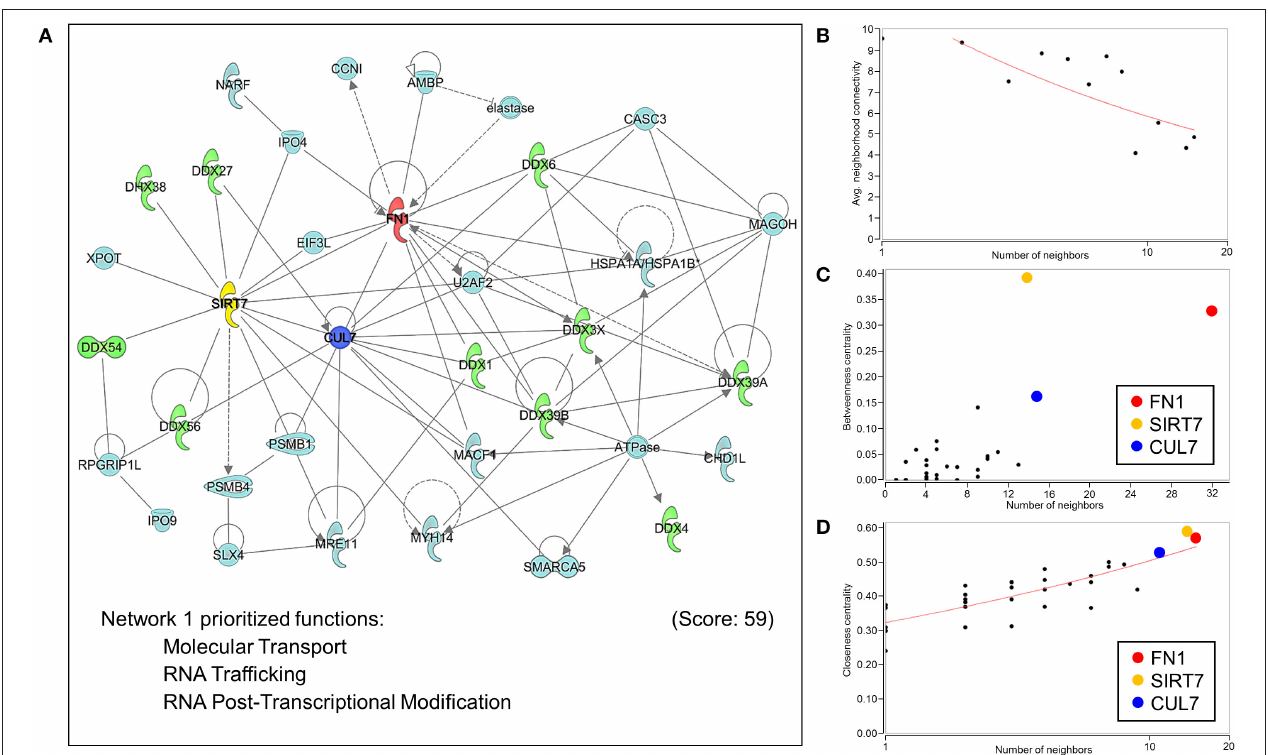
FIGURE 6 | Network analysis of protein-protein interactions of NUP155. NUP155 forms a subnetwork that integrates and enriches specific functional families. (A) Network 1 was the highest scoring network comprised of 35 nodes that prioritized Molecular Transport, RNA Trafficking and RNA Post-Transcriptional Modification. Also shown is significant representation of RNA helicases (10 nodes) displayed in green. (B) Plotting average neighborhood connectivity against degree/number of neighbors for network 1 revealed disassortative mixing (red line), indicating presence of hubs within the network. (C,D) Topology analysis focused on betweenness centrality and closeness centrality revealed the three top hubs as FN1 (red node), SIRT7 (yellow node) and CUL7 (blue node), implicating the role of these three hubs in regulating subnetwork integrity and informational